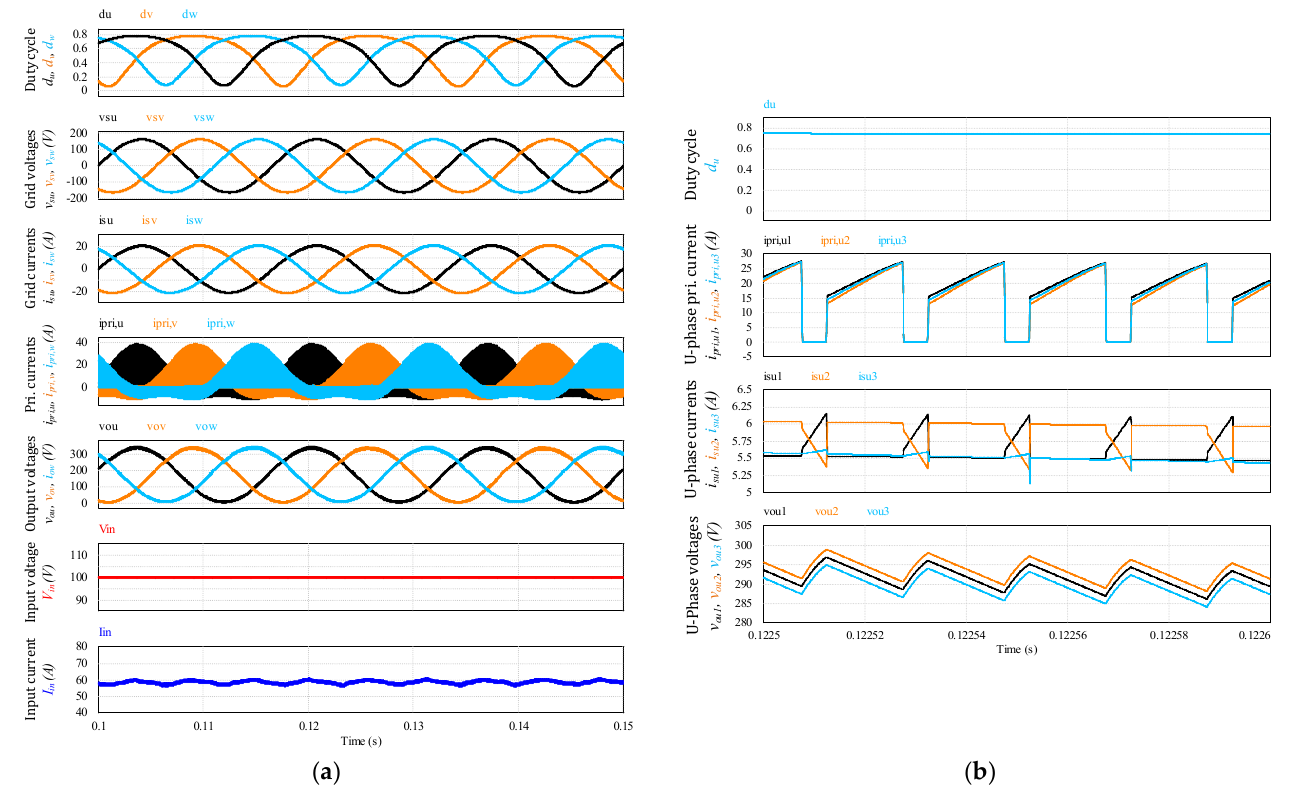
Figure 13. Simulation results of the proposed MFBDI at 5 kW considering 15% parameter mismatch. ( a ) Power frequency waveforms; ( b ) switching frequency waveforms. Table 6. Parameter mismatch of the proposed MFBDI.